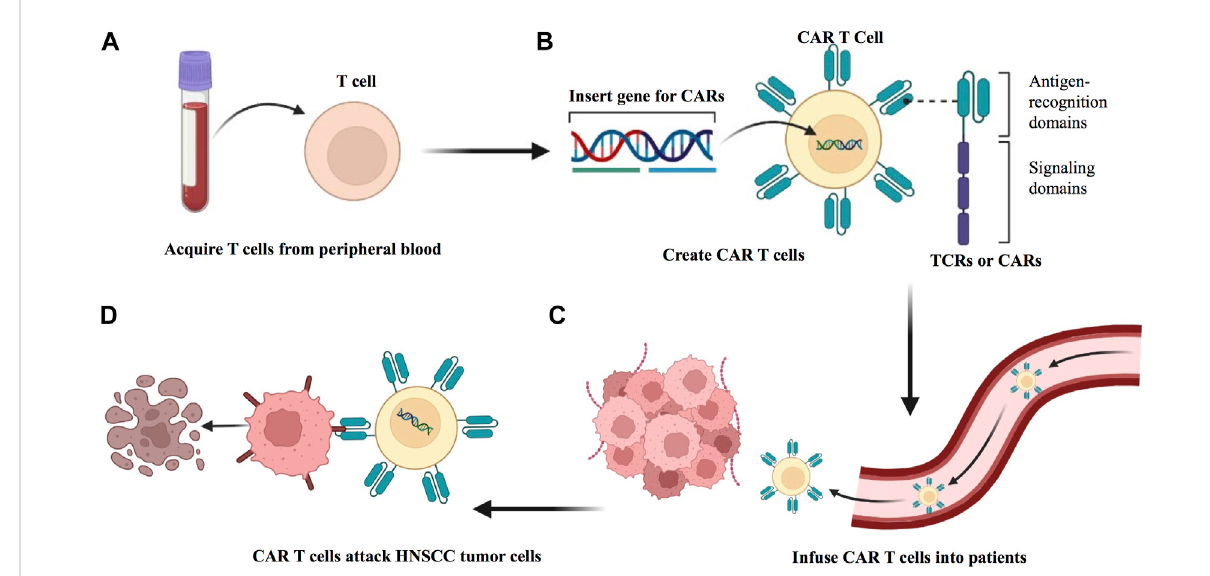
Preparation of ACT to treat HNSCC. (A) Adoptive transfer of antitumor T cells isolated from within the HNSCC tumor of the patient. (B) Tumor- in fi ltratingTcells(TILs)areextractedfromsurgicallyresectedtumorsamplesandthenexpanded invitro ,followedbyreinfusionintoHNSCCpatients. (C) T cells from patient peripheral blood are isolated and expanded in culture and genetically modi fi ed to express either a T cell receptor (TCR) or a chimeric antigen receptor (CAR). (D) The modi fi ed T cell confers the ability to speci fi cally recognize and killing HNSCC tumor